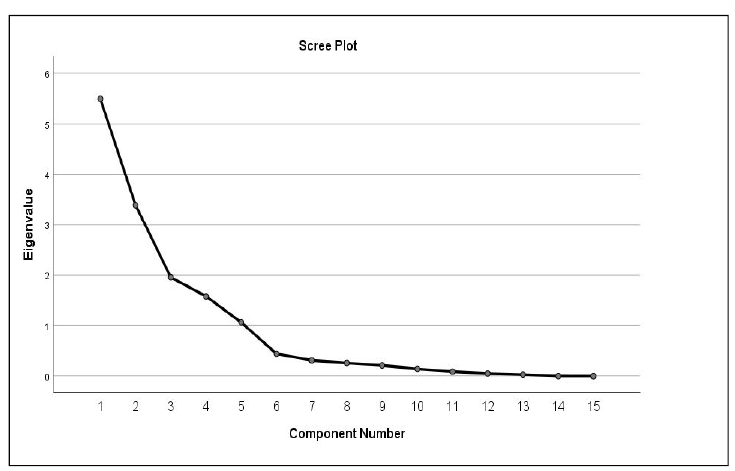
Figure A 1. Scree plot of the principal component analysis. n = 29. Figure A1. Scree plot of the principal component analysis. n =